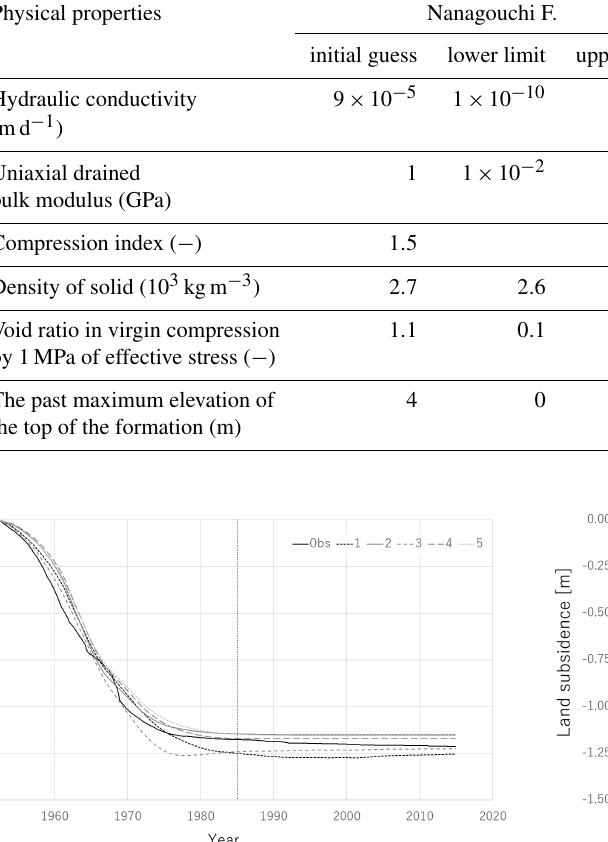
Figure 5. The variety of land subsidence prediction after the cali- bration in December